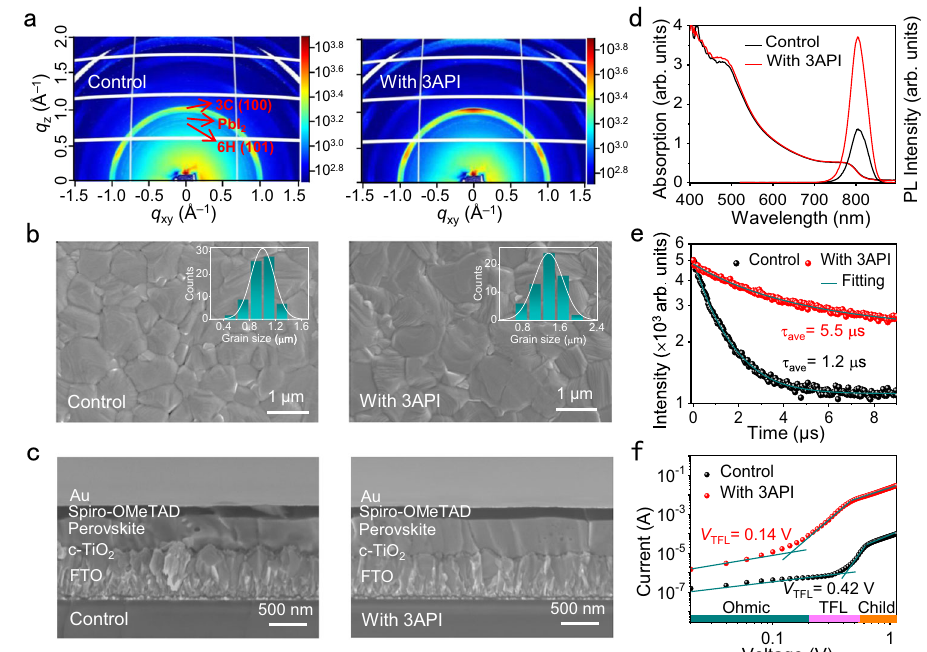
Fig. 3 | Characteristics of the control and 3AP-based perovskite fi lms. a Two- dimensionalGWIAXSimagesofthe fi naltwo fi lmsobtainedafterthermalannealing. b SEM images of the fi nal fi lms. The insets show the grain size distributions. c The cross-sectionalSEMimagesofthe fi nal fi lms. d Steady-stateUV – Visabsorptionand